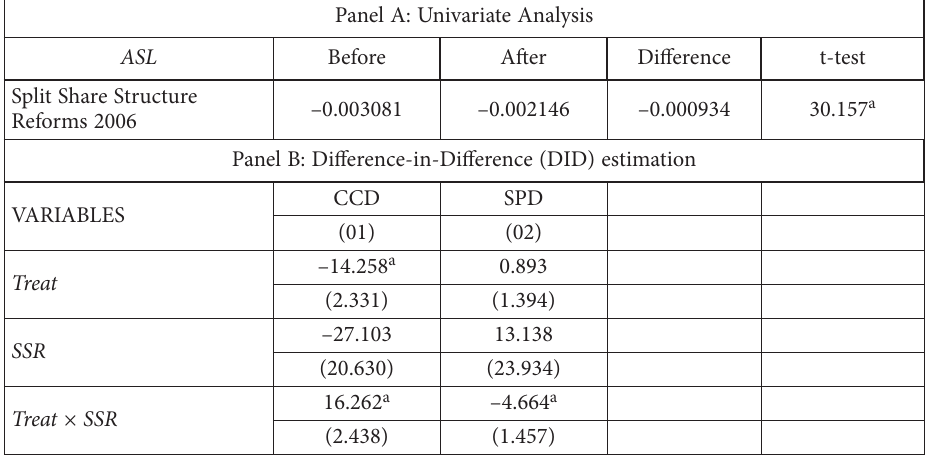
Panel A: Univariate